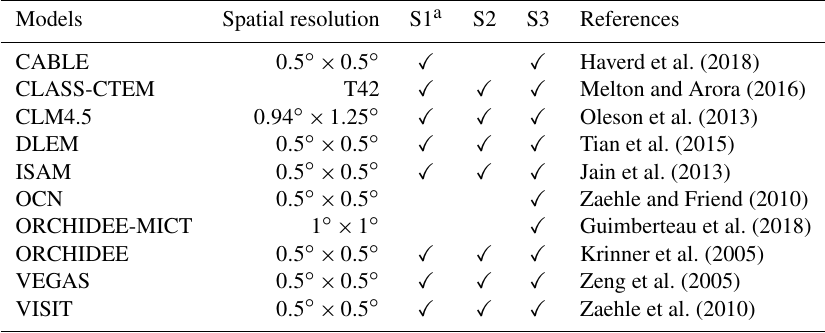
Table 1. Information of TRENDYv6 models used in this study. S1 represents the impact of the CO 2 fertilization effect, S2 represents the impact of the CO 2 fertilization effect and climate change, and S3 represents the impact of the CO 2 fertilization effect, climate change, and LUC.